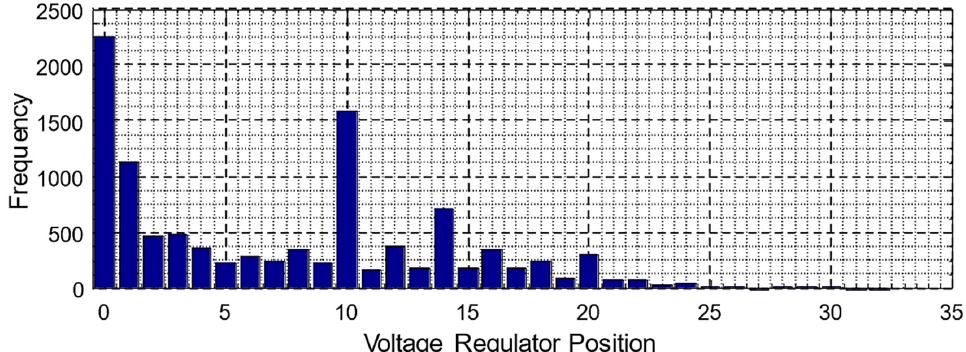
Figure 30. Frequency of socket positions taken by the on-load voltage regulator.